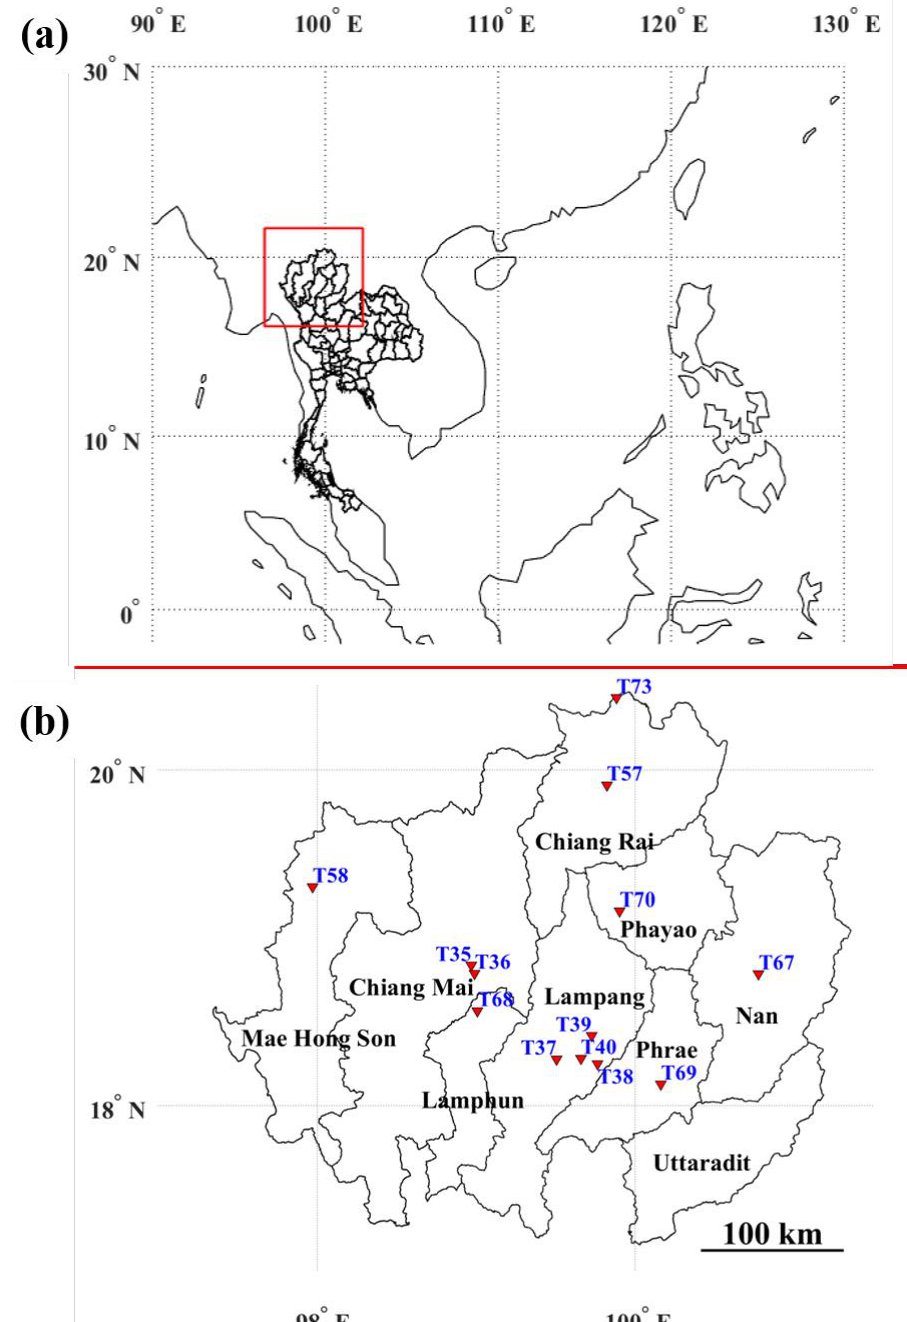
Figure 1. ( a ) Overview of the study area, which is in the red box. ( b ) Locations of 13 PM10 concentration measuring stations in the northern region of Thailand employed in this study, where black lines show boundaries of provinces.